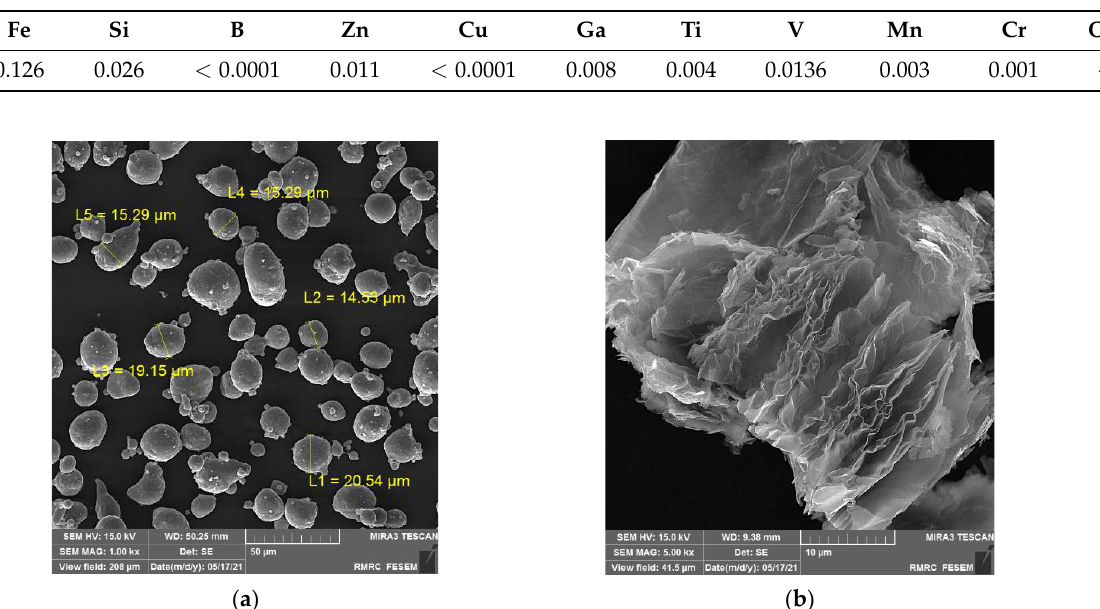
Table 1. Chemical composition of Al 1350 in weight percentages.